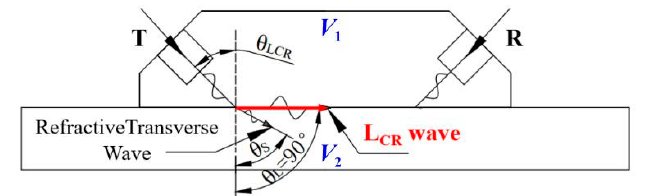
Figure 1. Mechanism of the L CR Wave.